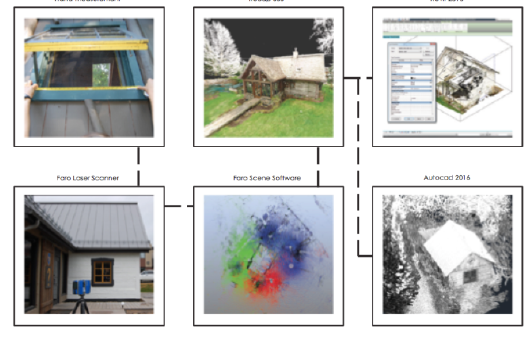
Figure 11. Survey workflow